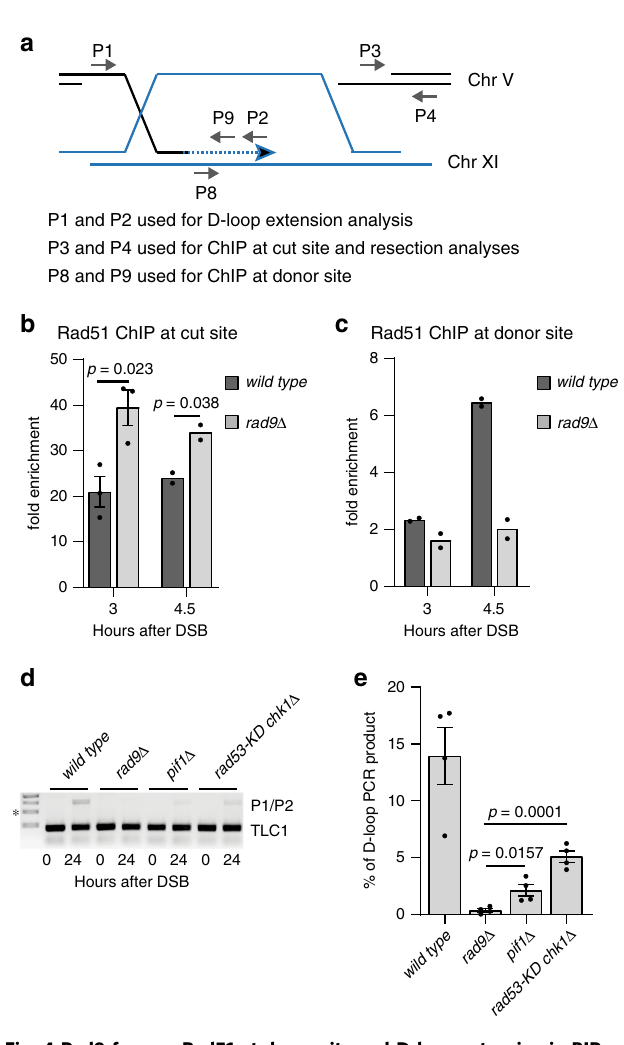
Fig. 4 Rad9 favours Rad51 at donor site and D-loop extension in BIR. a Scheme of the PCR-based assay to test D-loop extension and ChIP in JRL092 background. Rad51 enrichment at the cut site on chromosome V ( b ) at 3 ( n = 3, biologically independent experiments) and 4.5 h ( n = 2, biologically independent experiments), after DSB induction in the indicated JRL092 strains. Rad51 enrichment at the donor site on chromosome XI ( c ) at 3 and 4.5 h after DSB formation in the indicate JRL092 strains ( n = 2, biologically independent experiments). In both ( b ) and ( c ) the cells were blocked in G2/M with nocodazole. d PCR-based assay to test D-loop extension in the indicated JRL092 strains, (*) indicates the 1000bp band of the 1 kb DNA ladder (NEB). e Quanti fi cation of the D-loop extension in four independent experiments as in ( d ). All the data in the fi gure are presented as mean ± SEM wherever n = 3 or more. Statistical analysis was done using unpaired two-tailed Student ’ s t -test. See accompanying Source data fi